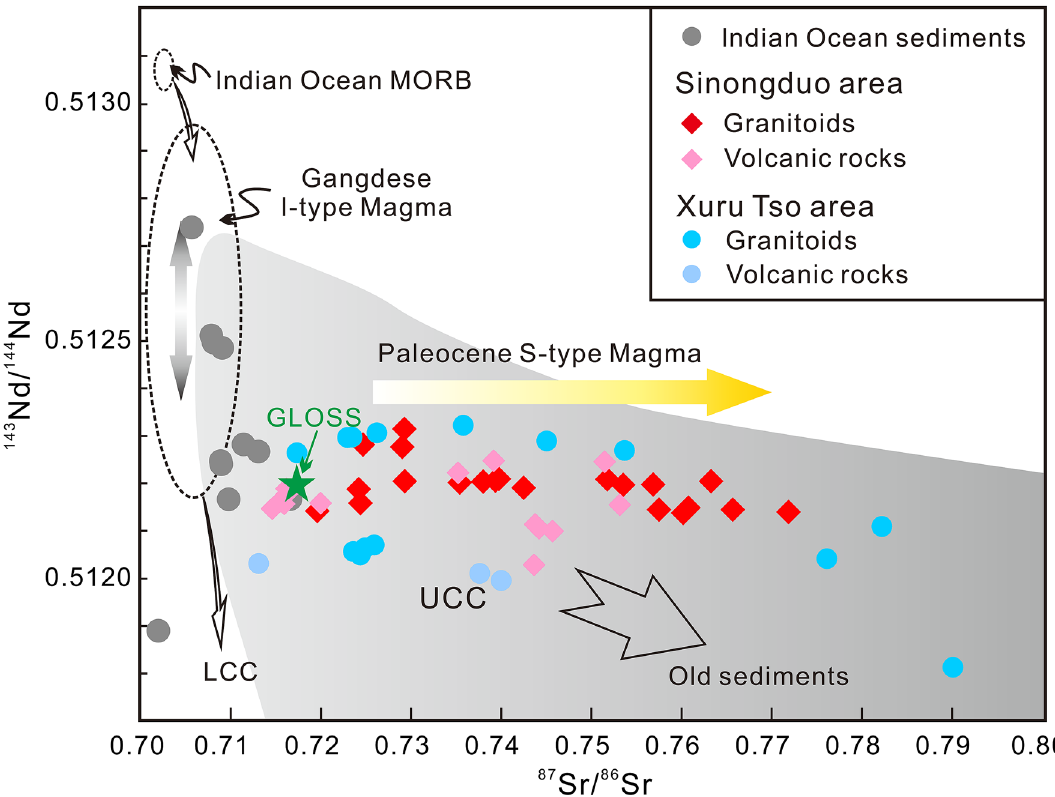
Figure 8. Isotopic evidence for UCC components in Paleocene magma from the Sinongduo area. (A) 87 Sr/ 86 Sr versus 143 Nd/ 144 Nd 42 for Paleocene magma from the Sinongduo area. Data from the Indian Ocean sediments 43 are plotted for comparison. Data for global subducting sediment (GLOSS) are from Plank and Langmuir 44 . Fields of UCC 42 , LCC 45 and Indian Ocean MORB 46 are obtained from the